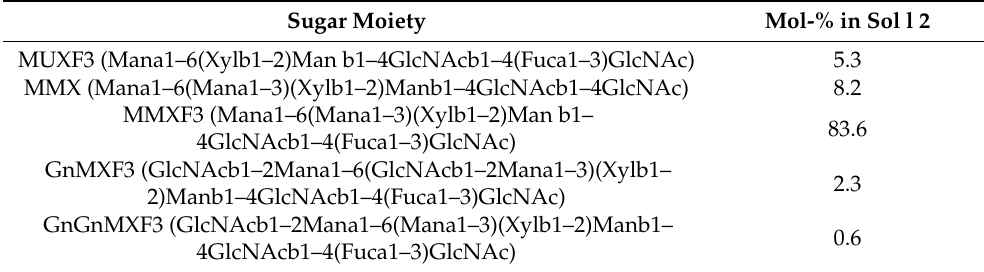
Table 5. Glycan structures identified in natural protein of Sol l 2 derived from tomato